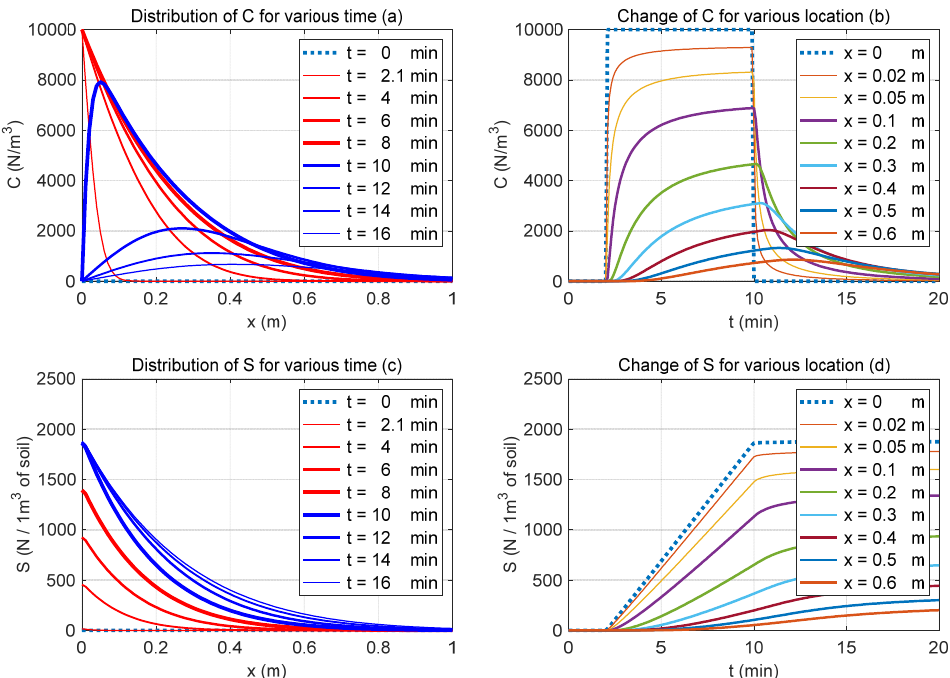
Figure 6. Simulation results for case S3 ( θ = 2 θ 0 ): ( a ) distribution of C at various times, ( b ) variation in C at various locations, ( c ) distribution of S at various times, and ( d ) variation in S at various locations.